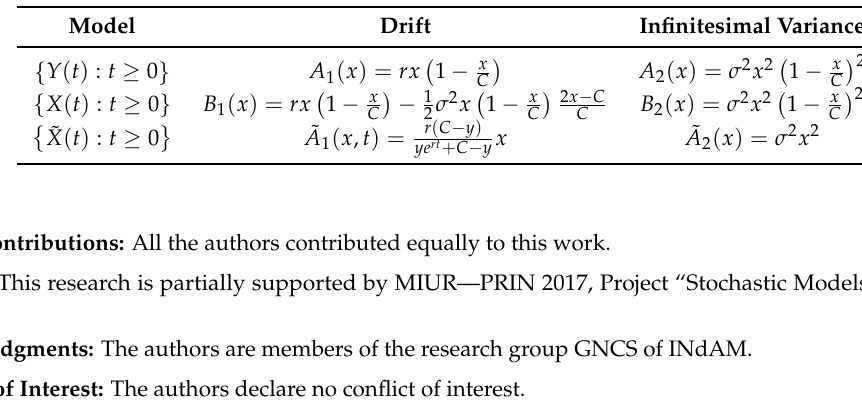
Table 8. The infinitesimal moments of the diffusion processes considered in Section